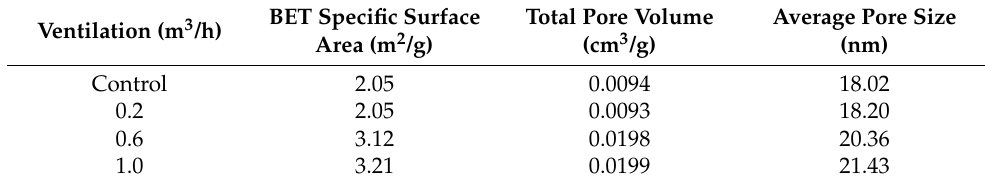
Figure 7. The adsorption–desorption isotherms ( a–c ) and the total pore volume ( d–f ) at different aeration rates. Table 8. Pore parameters of samples roasted at different